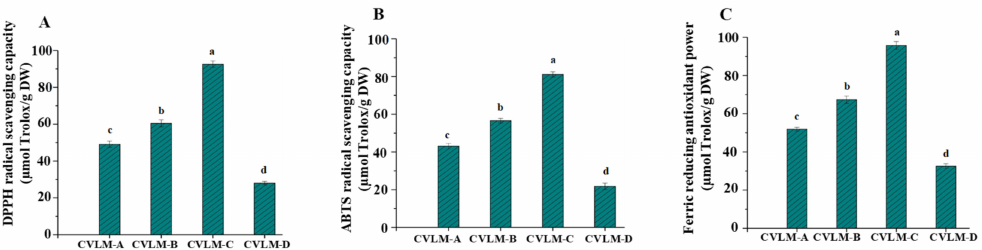
Figure 3. DPPH radical scavenging activities (A), ABTS radical scavenging activities (B) and ferric reducing antioxidant powers (C) of CVLMs. CVLM-A , CVLM-B , CVLM-C and CVLM-D , methanolic extractions from the leaves of C. violaceum collected from Chengdu, Langzhong, Bazhong and Guangyuan, respectively. Values represent mean ± standard deviation, and superscripts a–d di ff er significantly ( p < 0.05) among CVLMs collected from di ff erent regions. Statistical significances were determined by